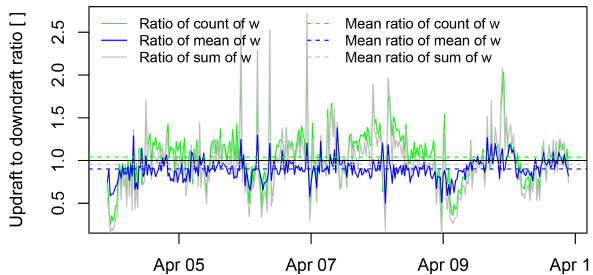
Figure 18. Ratio of statistical measures of vertical wind velocity of updrafts and downdrafts per 30min flux integration interval. The statistical measures are the ratio of the count, the mean, and the sum of vertical wind velocity records during updrafts and downdrafts, respectively (solid lines). The dashed lines indicate the temporal mean of the above statistics over the period